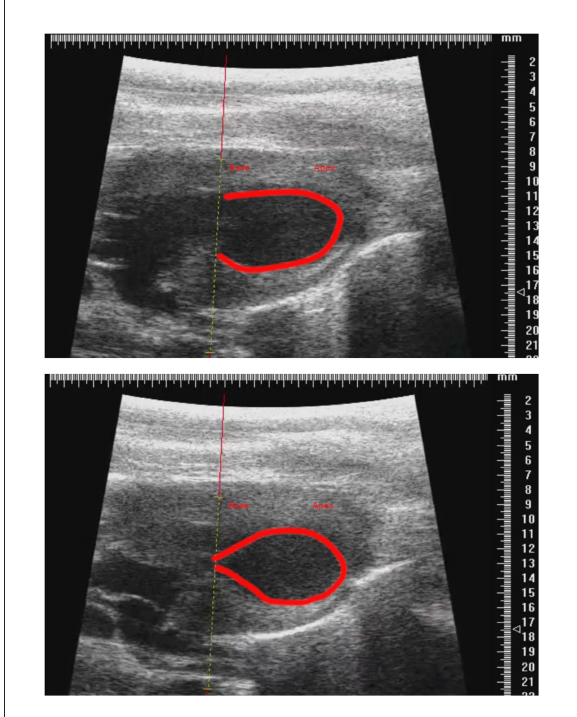
FIGURE6 Representative parasternal long axis B-mode images of end-diastole (top) and end-systole (bottom) after induction of TTS-like contractility (base: left; apex: right), with trace (red line) drawn around endocardial border. Scale in